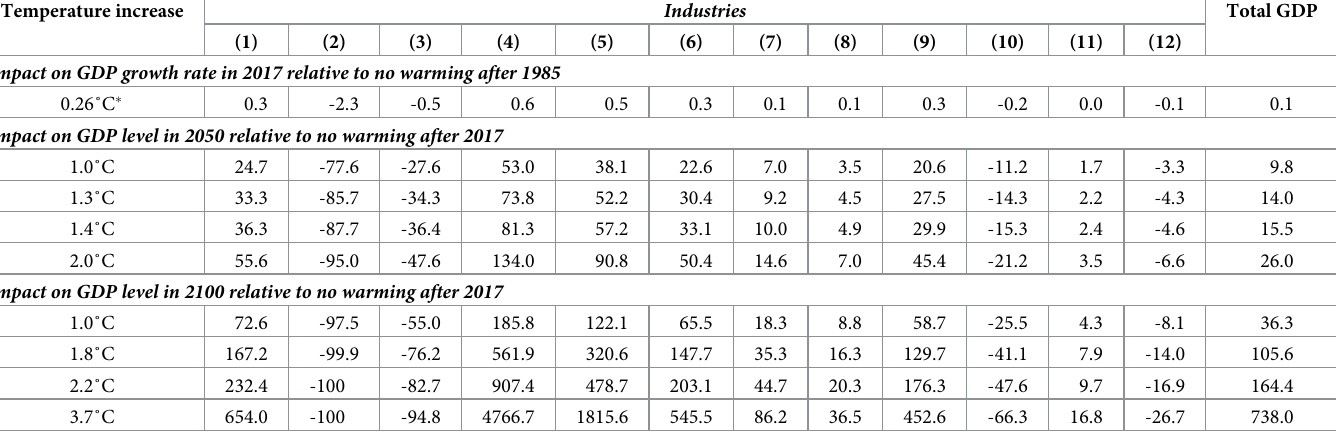
Table 7. Simulated impact (in %) of the climate change on the industry, overall GDP and growth rates in Chile for 1985–2017 and for future (monthly, all coeffi- cients, Table 5). Temperature increase Impact on GDP growth rate in 2017 relative to no warming after 1985 0.26˚C � Impact on GDP level in 2050 relative to no warming after 2017